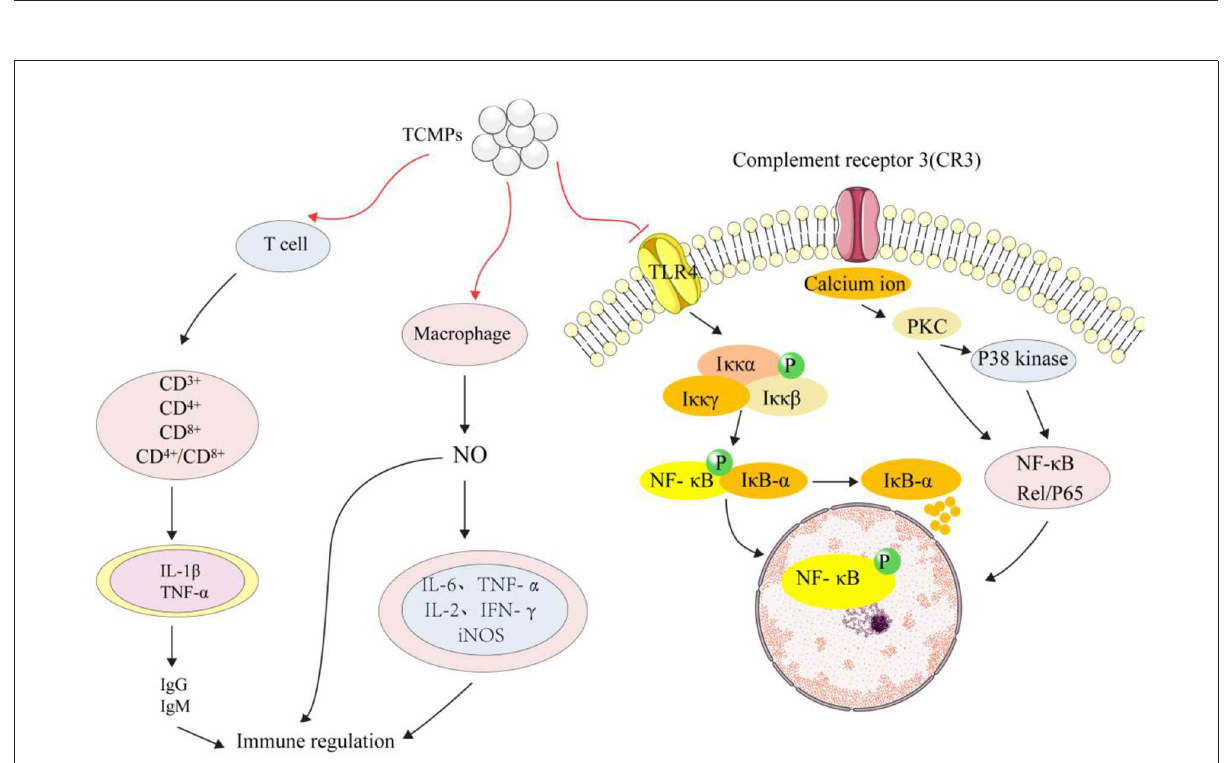
FIGURE4 The main immunomodulatory mechanism of